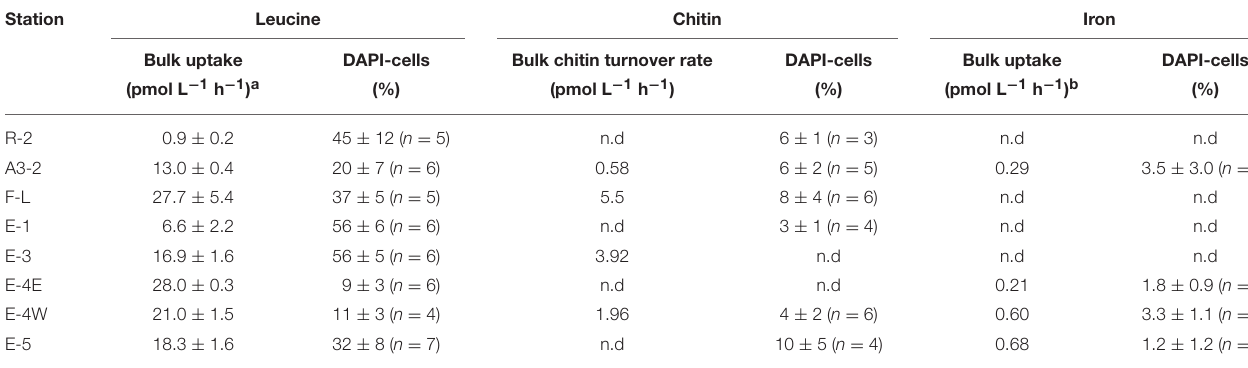
TABLE 2 | Bulk uptake rates and fraction of DAPI-cells taking up leucine, chitin and iron. Station Leucine Chitin Iron Bulk uptake DAPI-cells